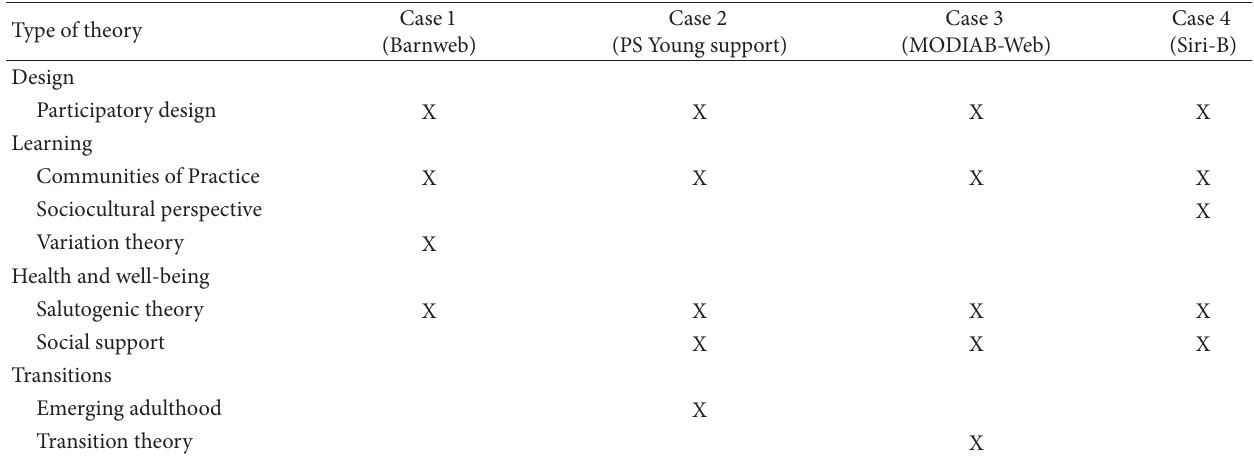
Table 2: Theories used in the development of web-based